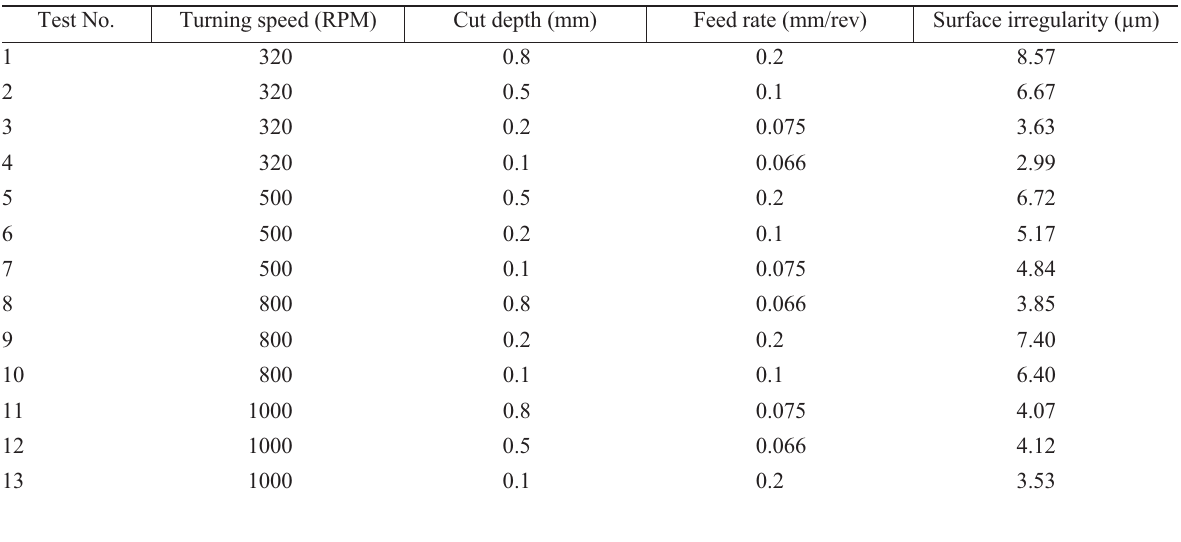
Table 2. Testing data for the neural network